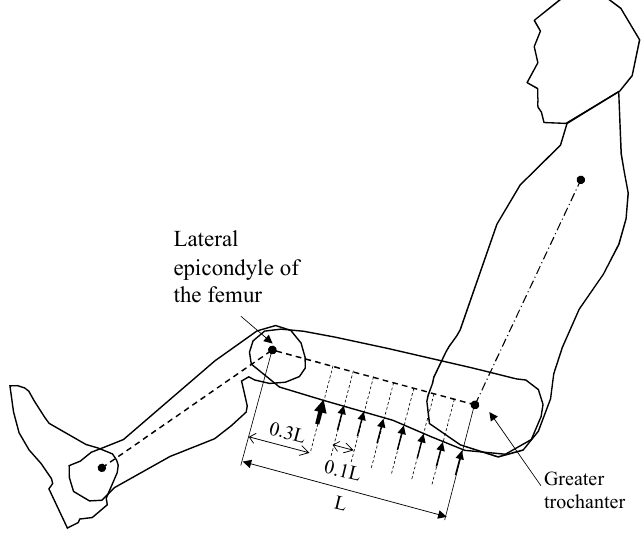
Figure 3. Measurement point at thigh and buttock.